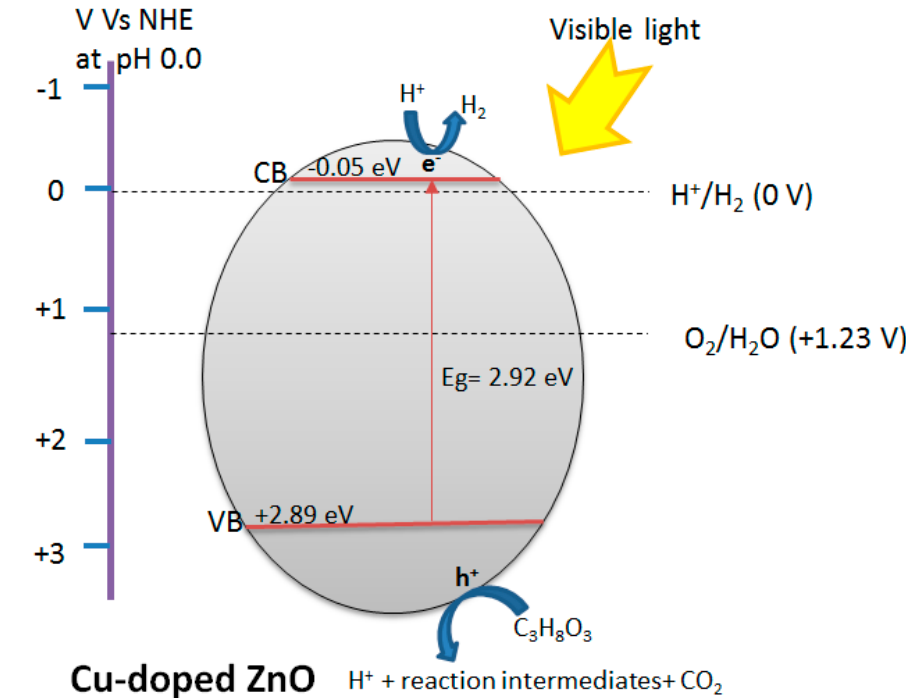
Figure 2. Proposed reaction mechanism for H 2 production from a glycerol aqueous solution using Cu-doped ZnO under visible light (CB: conduction band; VB: valence band).